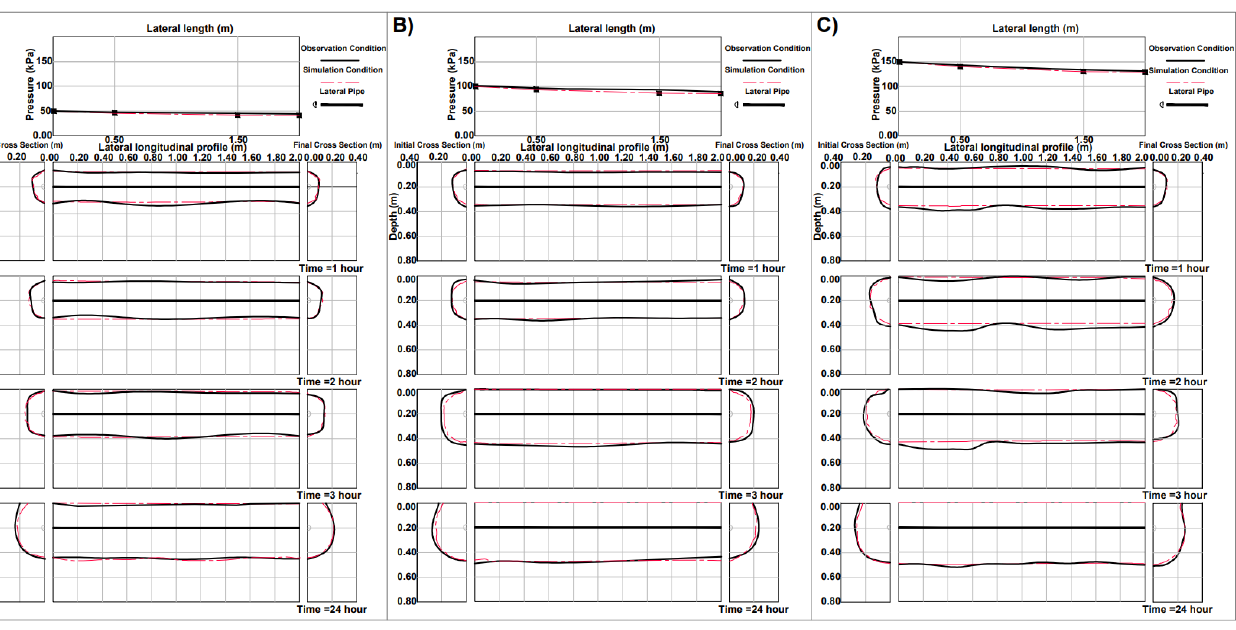
0.644 The largest and smallest wetted area corresponded to the highest and the lowest dis- charged volumes, equal to 0.105 and 0.009 m 3 , respectively. The mean flow rates of the